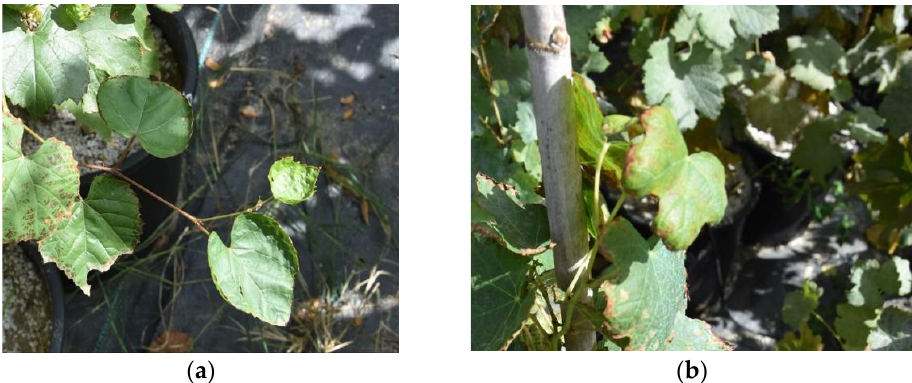
Figure 1. Leaf blade toxicity symptoms twenty-five days after 0.5 mM boron treatment of 101-14 Mgt rootstock ( a ) and own-rooted Merlot ( b ) vines. Table 3. The effect of boron toxicity on root, trunk, and shoot dry weight (g), of own-rooted or grafted onto 1103P and 101-14 Mgt rootstocks of Merlot and Cabernet Franc vine